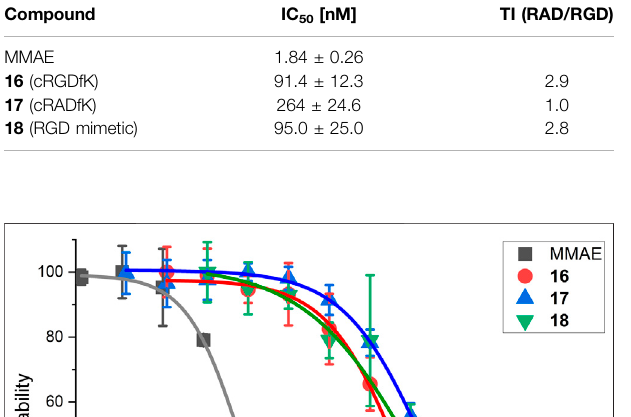
TABLE 6 | Cell adhesion assay of SMDC 16-18 in comparison to Cilengitide. WM115 cells were used as α V β 3 -positive cell line and M21-L as α V β 3 -negative cell line.